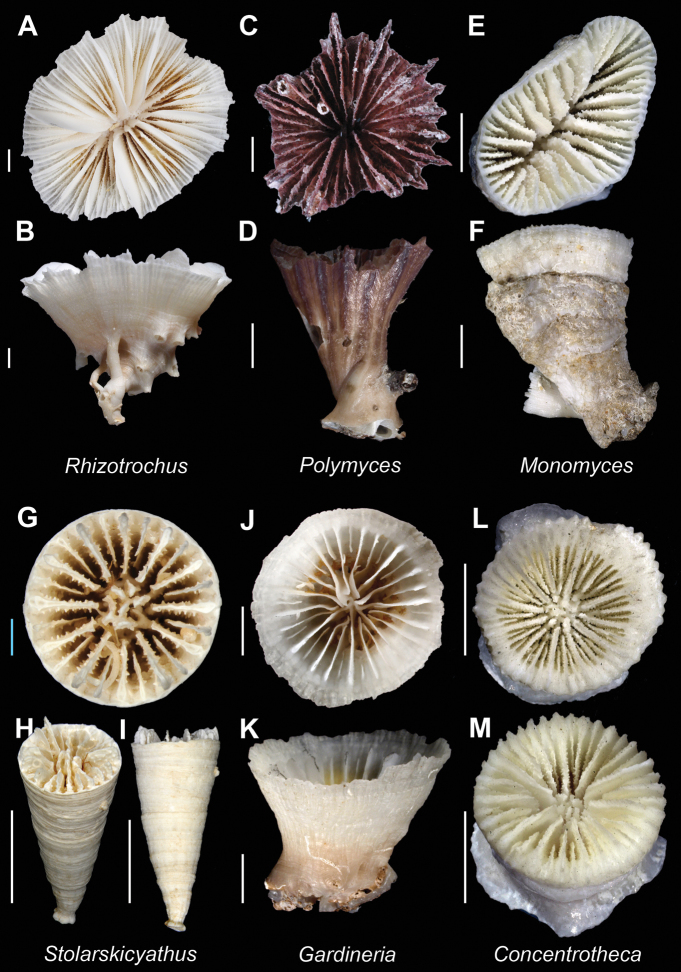
Rhizotrochus typus(USNM uncatalogued, Norfolk 2 stn. DW2024)A and B Calicular and lateral view respectively; Polymyces wellsi
C (MNHN uncatalogued, Ebisco stn. DW2618) and D (MNHN uncatalogued, New Caledonia): Calicular and lateral view respectively; Monomyces pygmaea(USNM 48561) E and F Calicular and lateral view respectively; Stolarskicyathus pocilliformis(MNHN uncatalogued, Ebisco stn. DW2573) G, H, and I Calicular, oblique, and lateral view respectively; Gardineria hawaiiensis(USNM uncatalogued, Norfolk 2 stn. DW2086) J and K Calicular and lateral view respectively; Concentrotheca laevigata(USNM 80748) L and M Calicular and oblique view respectively. Scale bars: blue = 1 mm; white = 5 mm. Bold face indicates type species for the genus.